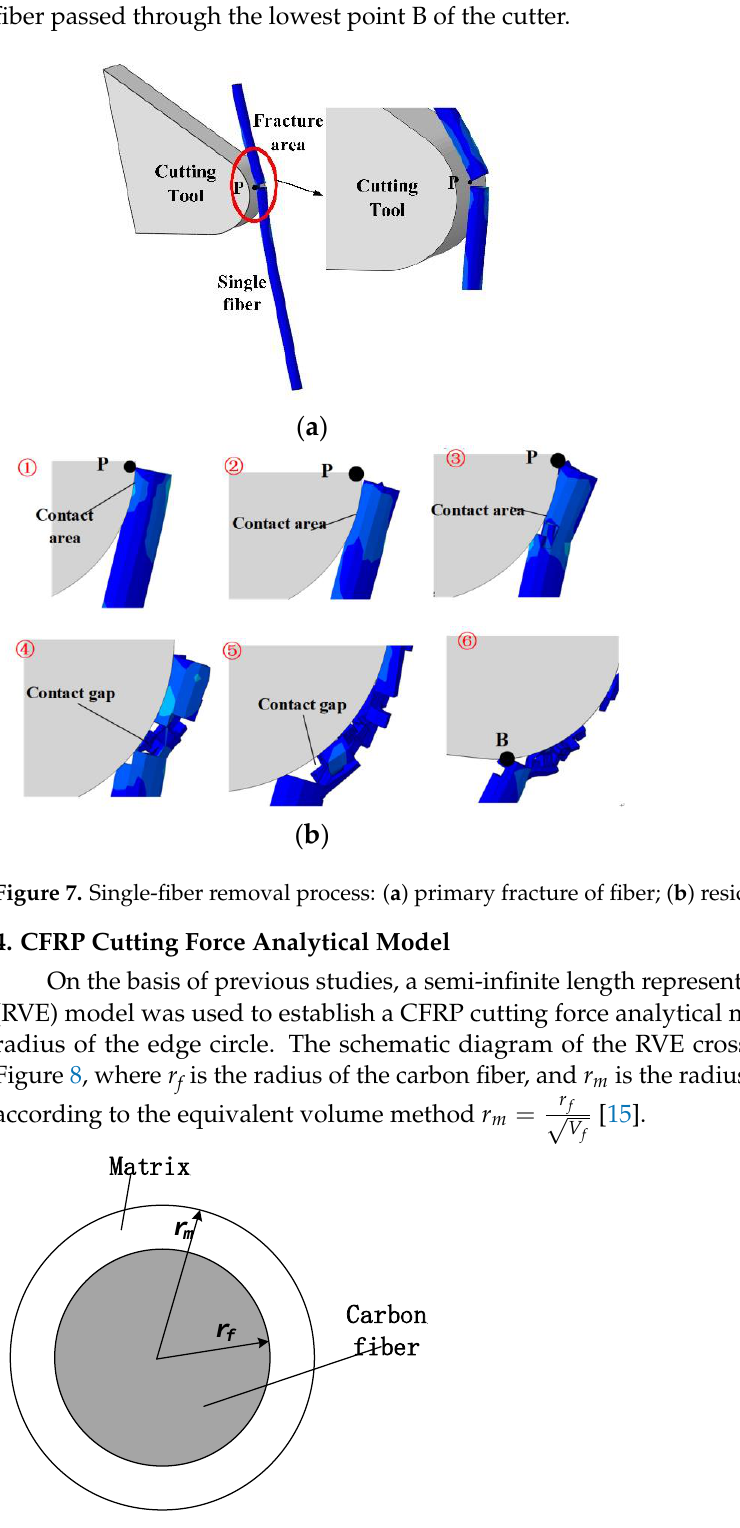
Figure 8. The schematic illustration of RVE cross-section.